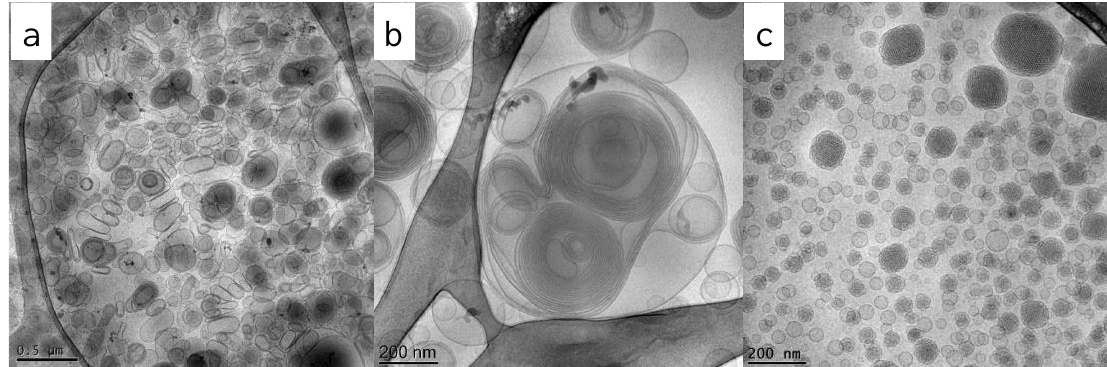
Figure 4. Cryo-TEM images of empty liposomes ( a ), ethosomes ( b ), and cubosomes ( c ). A very short wavelength of accelerated electrons can provide very high resolution imaging [103]. The morphology of nanosystems is highly dependent on the type of lipid and other components employed. The study aimed at production of NLC using different solid lipids (i.e., tristearin, compritol, precirol, or suppocire) and a liquid lipid (i.e., caprylic/capric triglycerides) for the cutaneous delivery of α-tocopherol. The NLC mor- phology was investigated via cryo-TEM and the shape appears discoid in the top view and more electron-dense and rodlike in the edge-on view, while a roundish shape has been observed in the case of NLC made up of tristearin, both for unloaded and loaded NLC. Ovoid and triangular structures were observed in NLC with compritol and preci- rol. Lastly, in the case of NLC with suppocire, besides the presence of some irregular structures, spherical structures were detected, resembling vesicles rather than solid par- ticles [94].